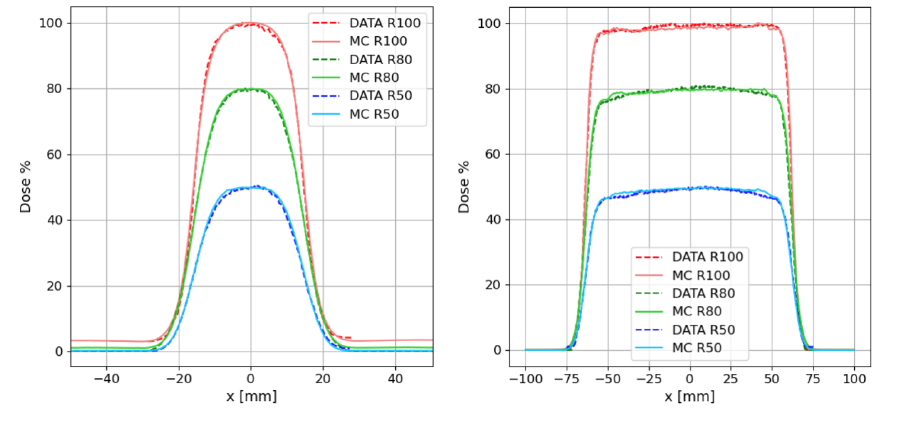
Figure 8. Measured (dotted line) and simulated (continuous line) transverse profile in the PMMA phantom obtained for the 5 MeV electrons beam collimated with the A-d30 ( left ) and A-d120 ( right ) applicators. The figures show the profiles obtained at 7 mm (R100), 11 mm (R80), and 14 mm (R50) depth.